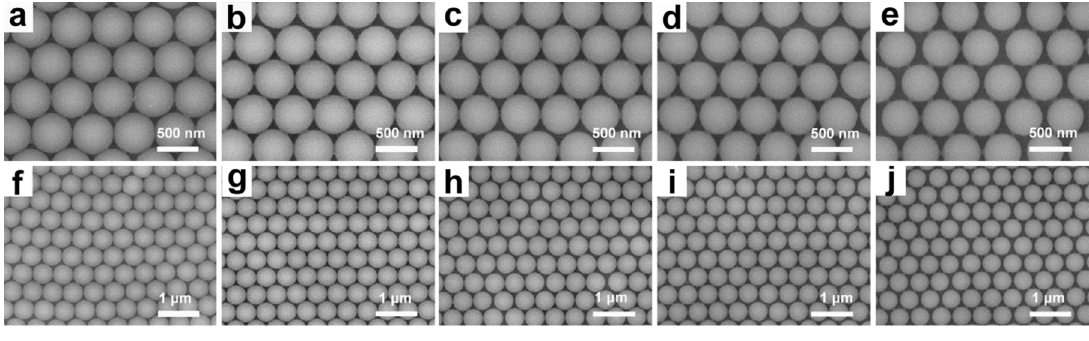
Figure 1. SEM images of the ncp MCCs after etching: ( a , f ) top views of ncp MCCs-0; ( b , g ) top views of ncp MCCs-2; ( c , h ) top views of ncp MCCs-4; ( d , i ) top views of ncp MCCs-6; and ( e , j ) top views of ncp MCCs-8.